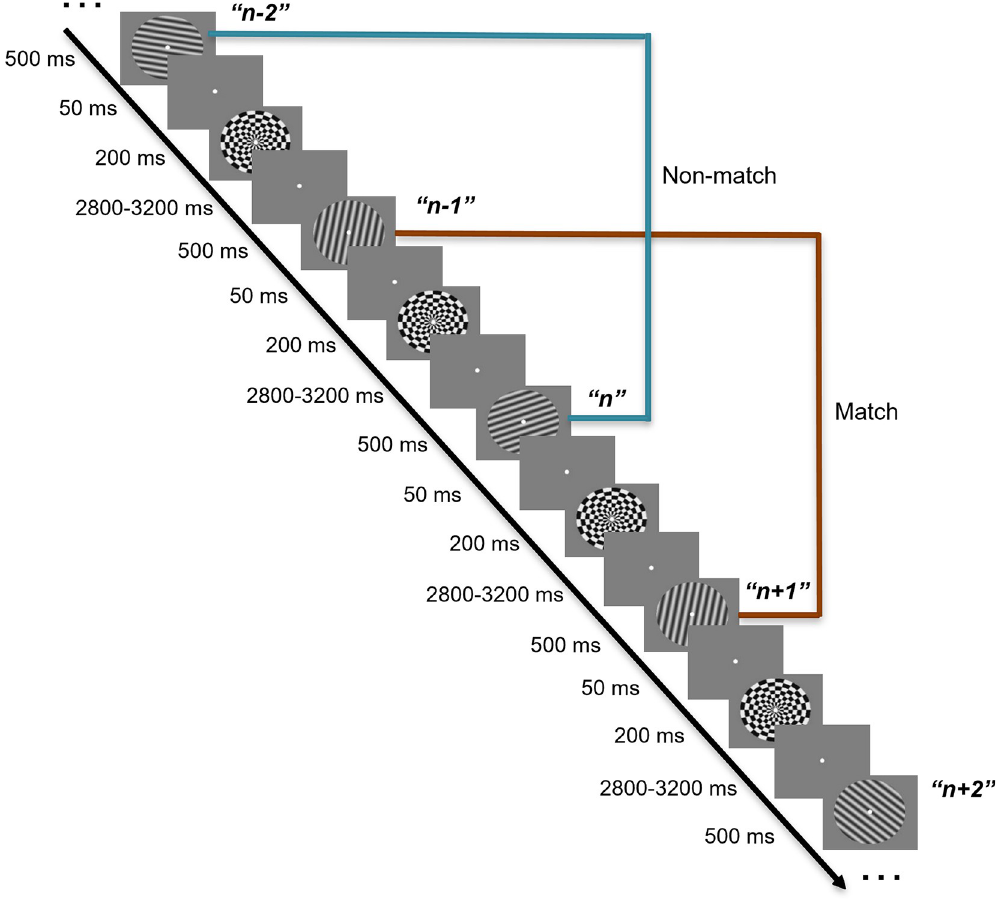
Fig 1. 2-back task structure in the Wan et al. [13] EEG study. The presentation of each stimulus is followed by a 50 ms blank screen, a 200 ms radial checkerboard mask, a variable delay from 2.8 to 3.2 s, and then the next stimulus was presented, upon which the match vs. non-match response is to be